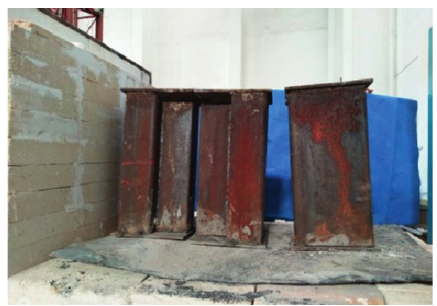
Figure 5: Some of the specimens after cooling.